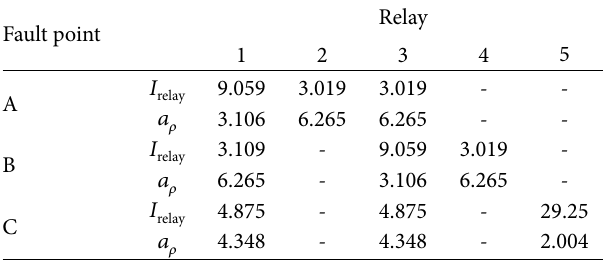
Figure 7: Comparison of the graphical representation of the optimal TMS with the RTO algorithm and GA for Case 2.